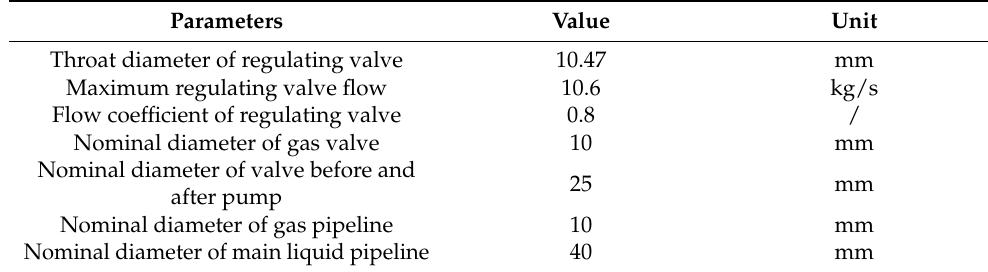
Table 4. Main parameters of the regulating valve and the pipelines. Parameters Value Unit Throat diameter of regulating valve